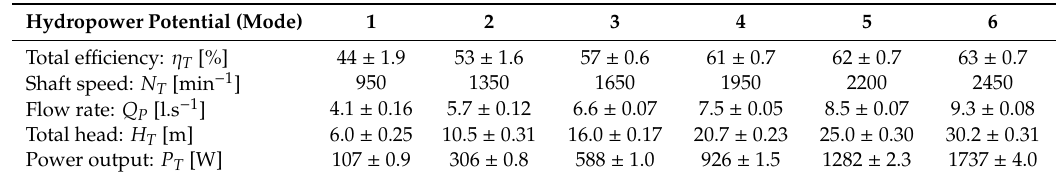
Table 2. Performance parameters of tested PAT at BEP.